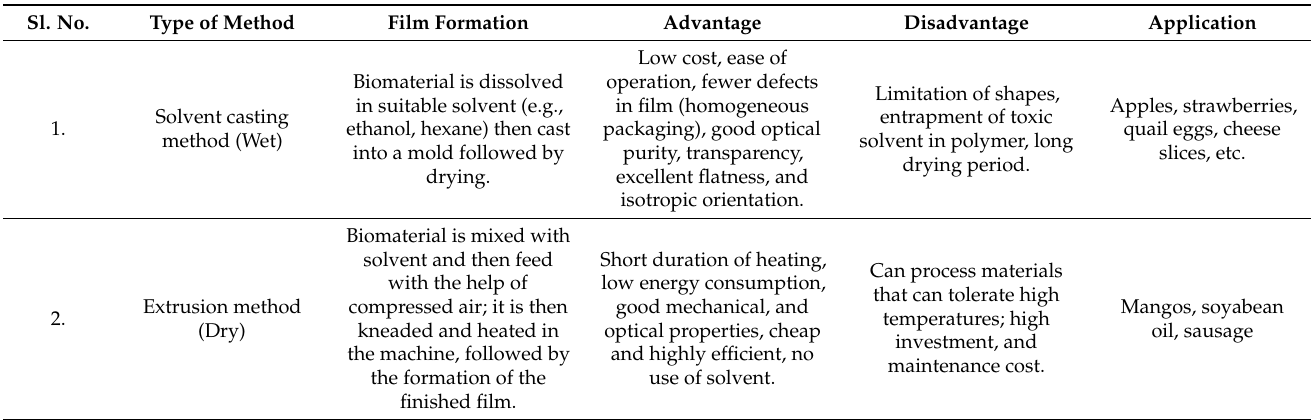
Table 3. Outline comparing dry and wet methods of film formation